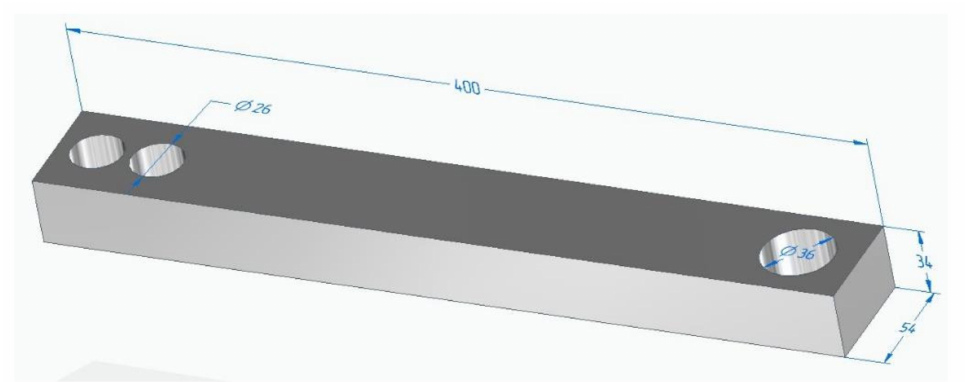
Figure 2. Simplified model of the sample for